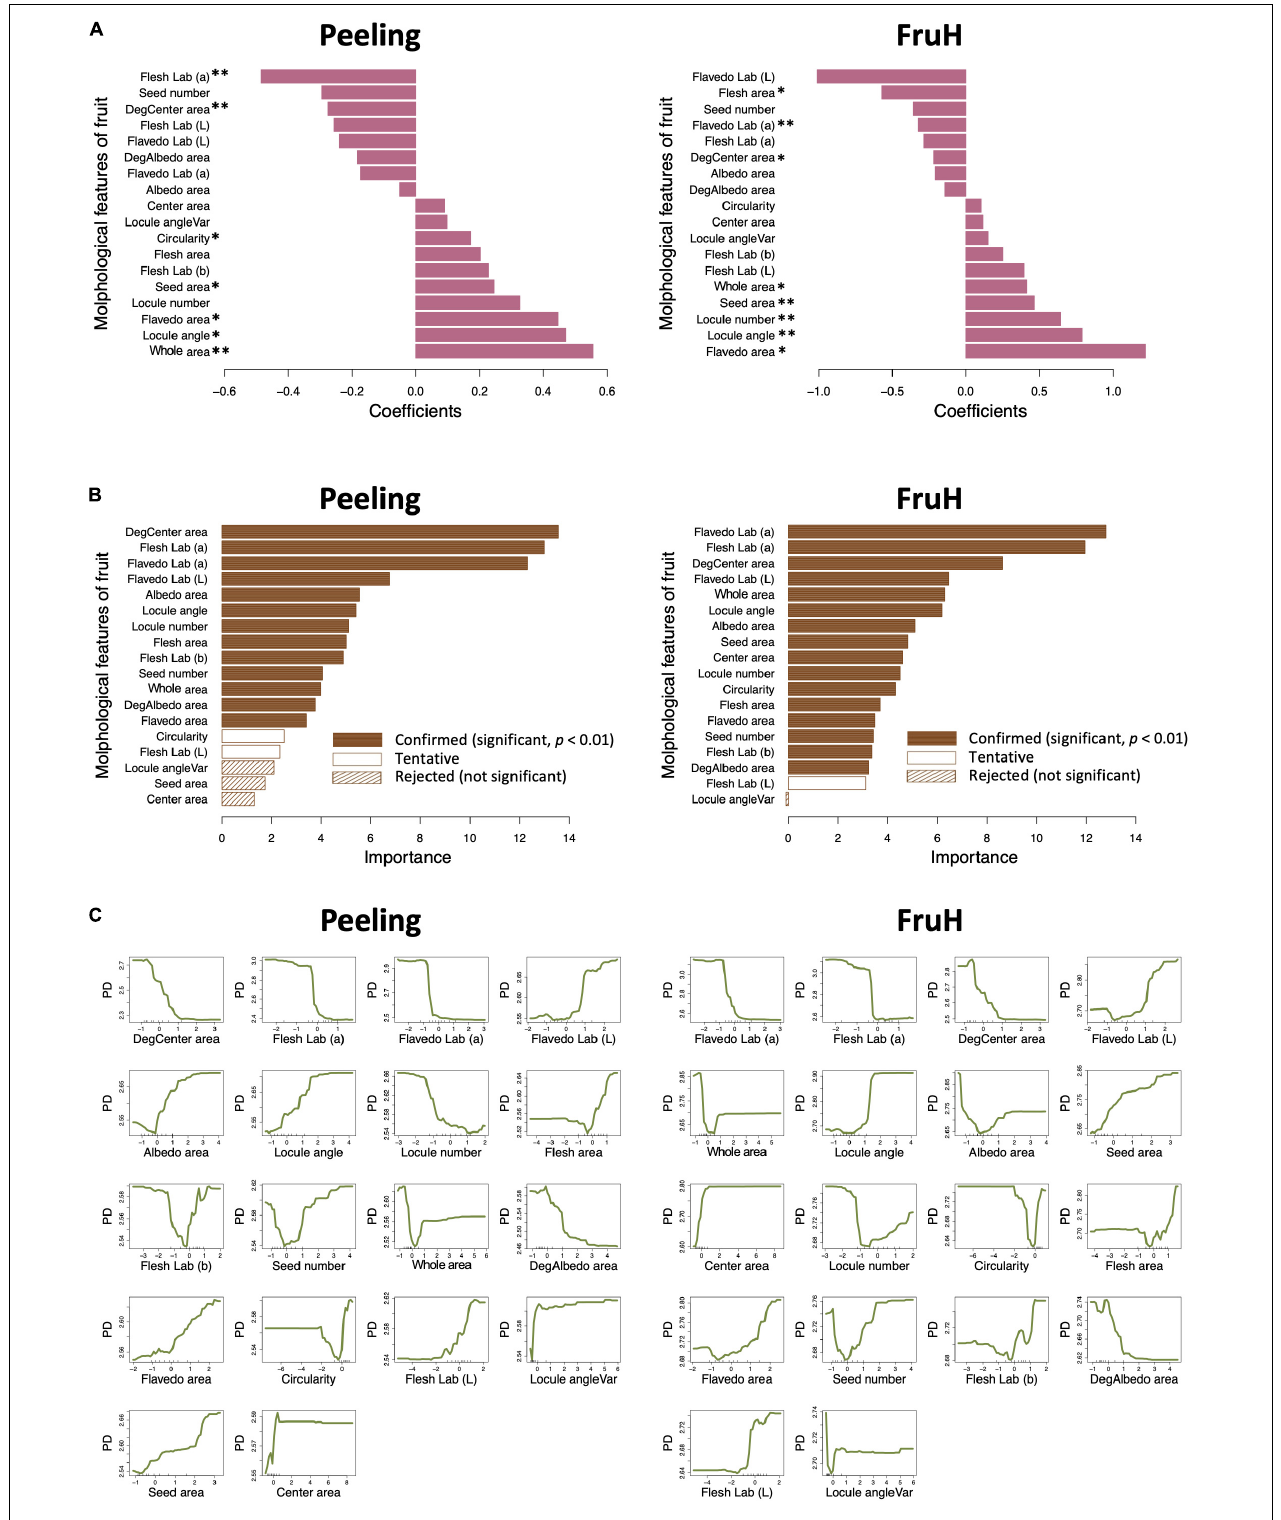
FIGURE 3 | Associations between fruit morphological features and breeder-evaluated fruit quality traits using multiple linear regression and random forest. (A) Regression coefficients estimated using multiple linear regression (MLR). Asterisks indicate statistically significant correlations: ∗ p < 0.05; ∗∗ p < 0.01. (B) Variable importance in the random forest (RF) model. (C) Partial dependence calculated for the RF model.